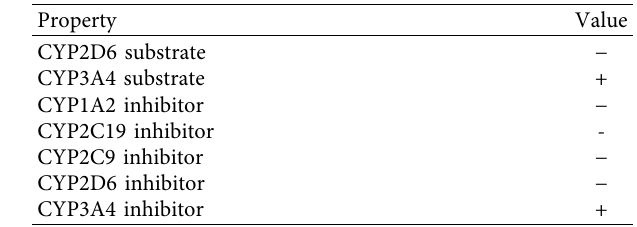
Table 9: Metabolism properties of the alternaramide marine